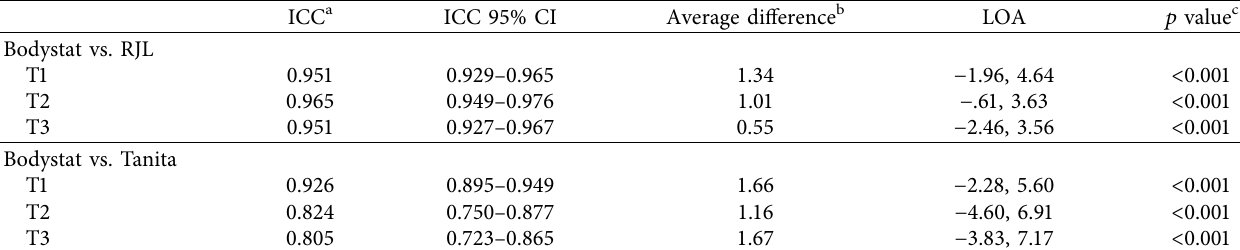
Table 3: Reproducibility in the method comparison of Bodystat, RJL, and Tanita for estimation of TBW%.